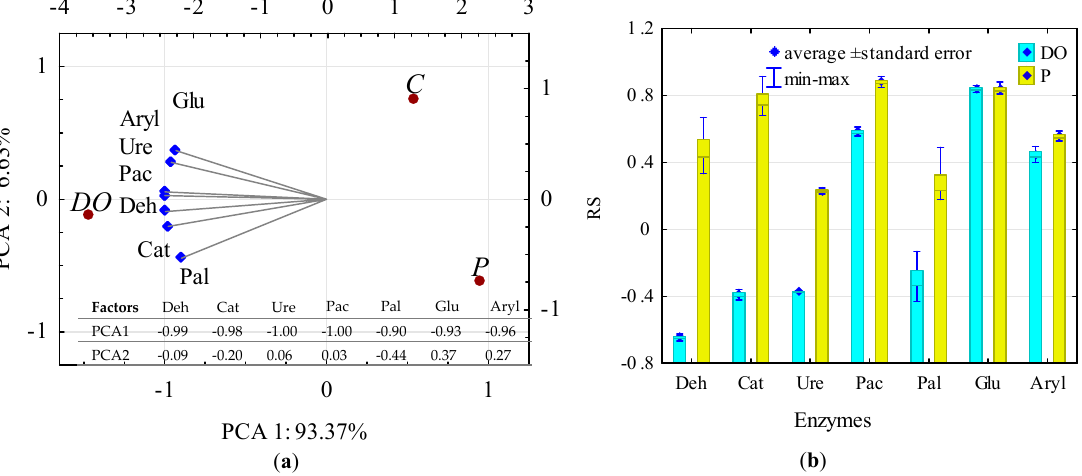
Figure 7. Activity of soil enzymes ( a ) presented with the PCA method; ( b ) enzyme resistance indices (RS) to soil contamination with diesel oil (DO) and unleaded petroleum (P). Deh—dehydrogenases; Cat—catalase, Ure—urease; Pac—acid phosphatase; Pal—alkaline phosphatase; Glu— β -glucosidase; Aryl—arylsulfatase. Homogeneous groups denoted with letters (a,b) were calculated separately for each of enzyme.